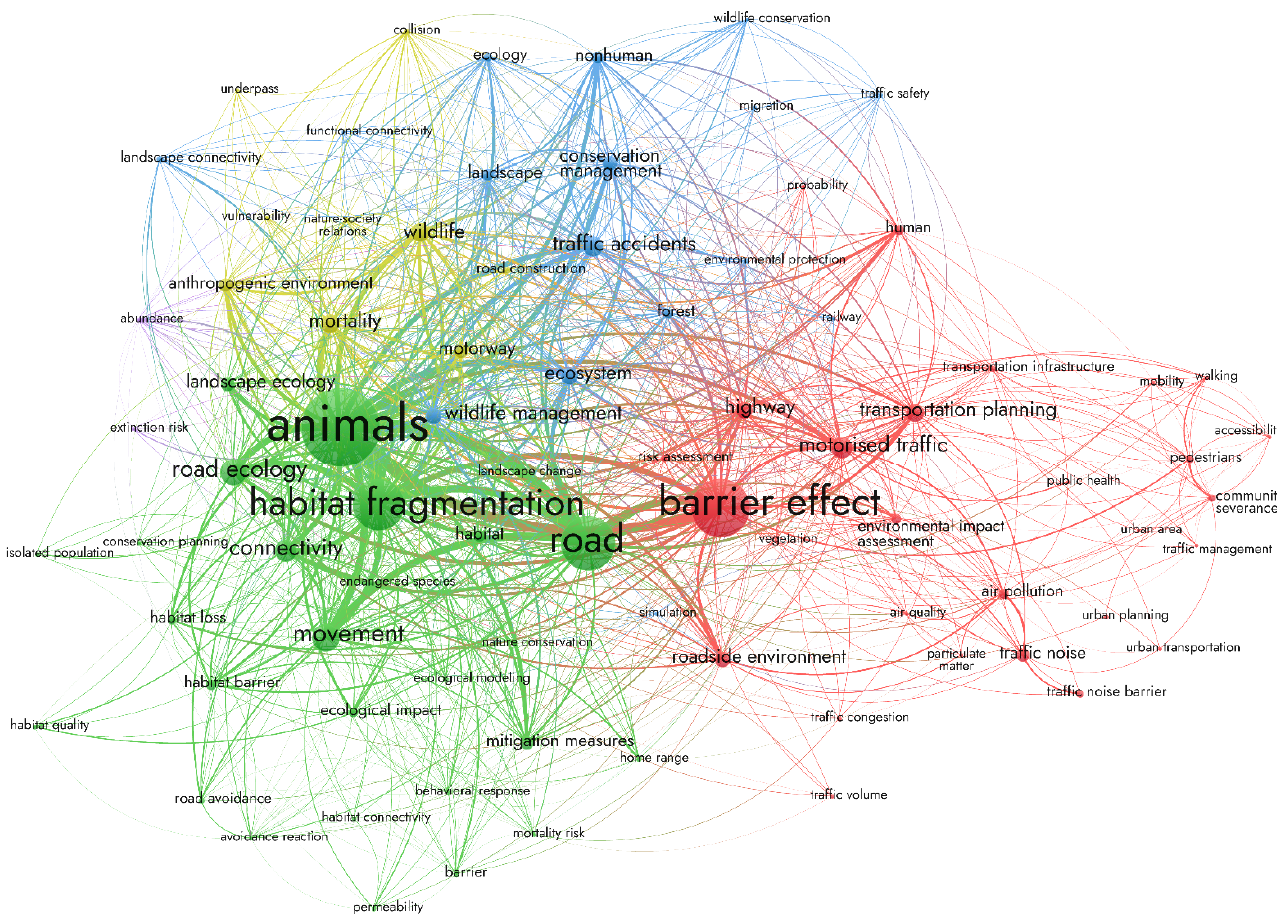
Figure 4. Keyword co-occurrence analysis of the relevant literature.